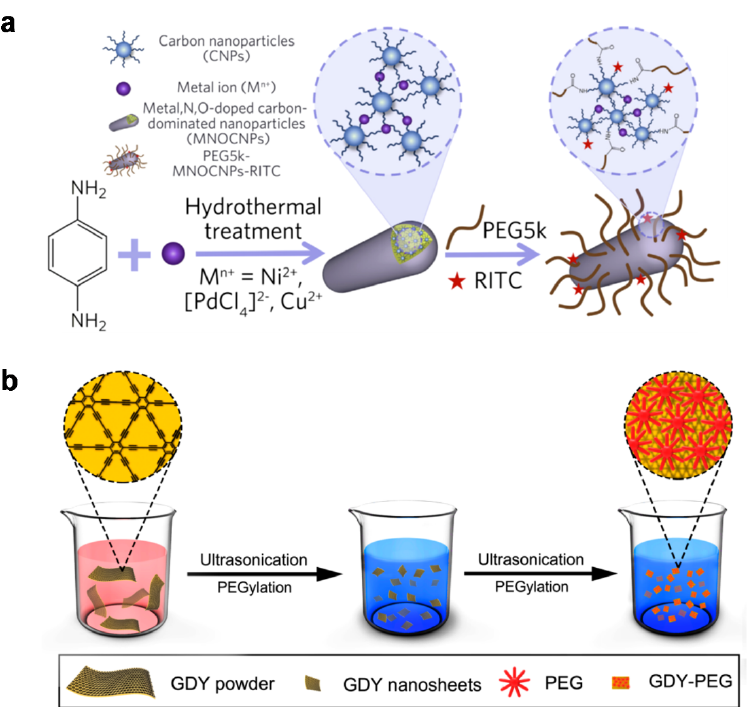
Figure 13. ( a ) Schematic illustrations of hydrothermal preparation and further modification of metal, N, O-doped carbon nanoparticles (MNOCNPs). Reprinted with permission from